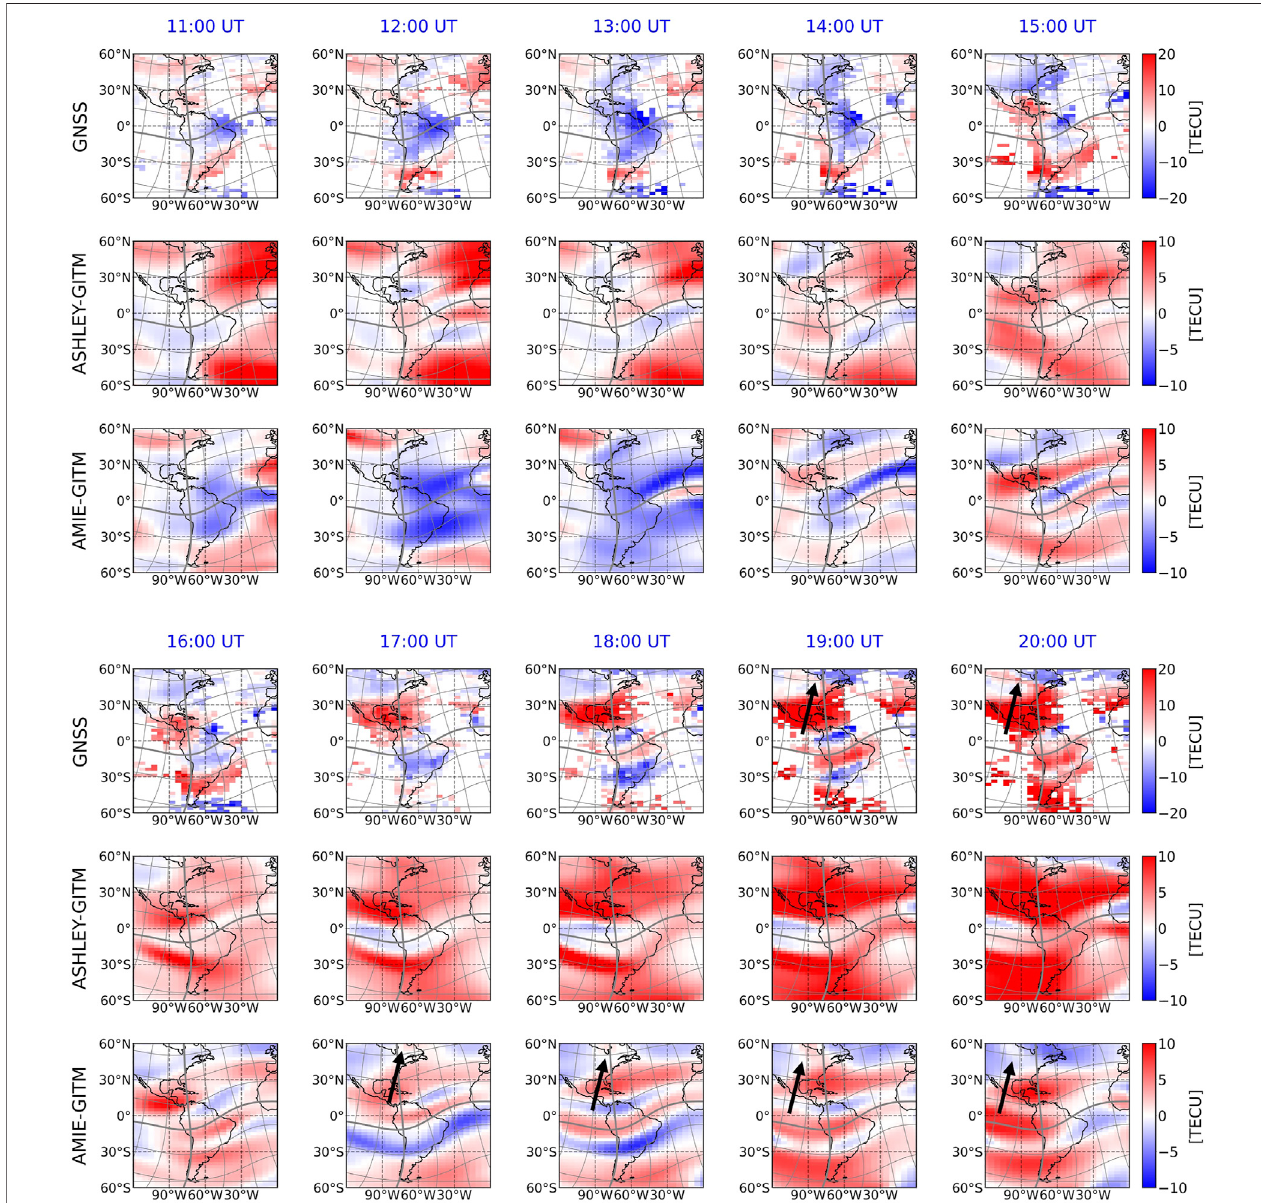
FIGURE 2 | Comparisons of the storm-quiet differential TEC in the American sector at different UTs. At each UT, from top to bottom, the results correspond to thosecalculatedfromtheGNSSdata,ASHLEY-drivenandAMIE-drivenGITMsimulationoutputs,respectively.NotethatthecolorscaleissmallerforthedifferentialTEC calculated from the GITM simulation output. The grey lines indicate the Apex magnetic coordinate, with the MLON and MLAT having a 20 ° spacing. The 0 ° MLON and MLAT are marked by the thick grey lines. Black arrows indicate the SED plume. TEC, total electron content; UT, universal time; ASHLEY, Auroral Spectrum and High-Latitude Electric fi eld variabilitY; GITM, Global Ionosphere Thermosphere Model; MLON, magnetic longitude; MLAT, magnetic latitude; GNSS, Global Navigation Satellite System; SED, storm-time enhanced density.